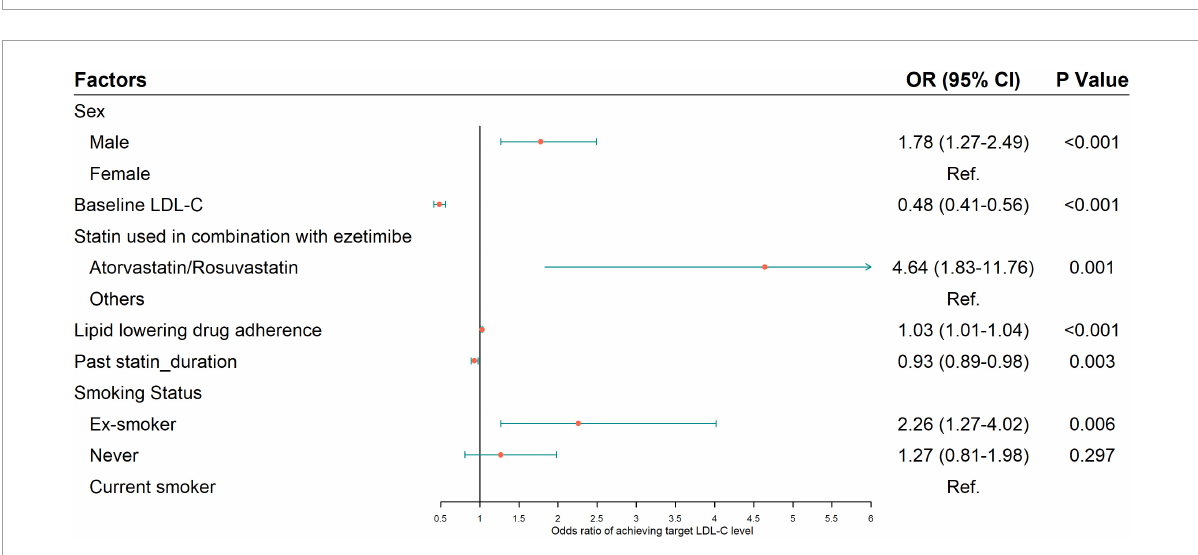
FIGURE4 Factors associated with LDL-C target value achievement rate from multivariable logistic regression. Variables in the original model included age, sex, statins used in combination with ezetimibe, baseline LDL-C, body mass index, smoking status, alcohol consumption, exercise habits, lipid lowering drug adherence and treatment courses of statin and ezetimibe. A bidirectional stepwise process was applied to select variables to be included in the final model. OR, odds